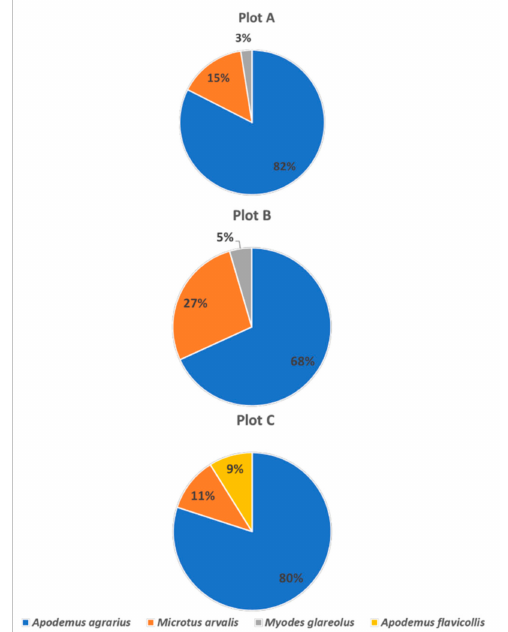
Figure 2. Structure of flea hosts in the study